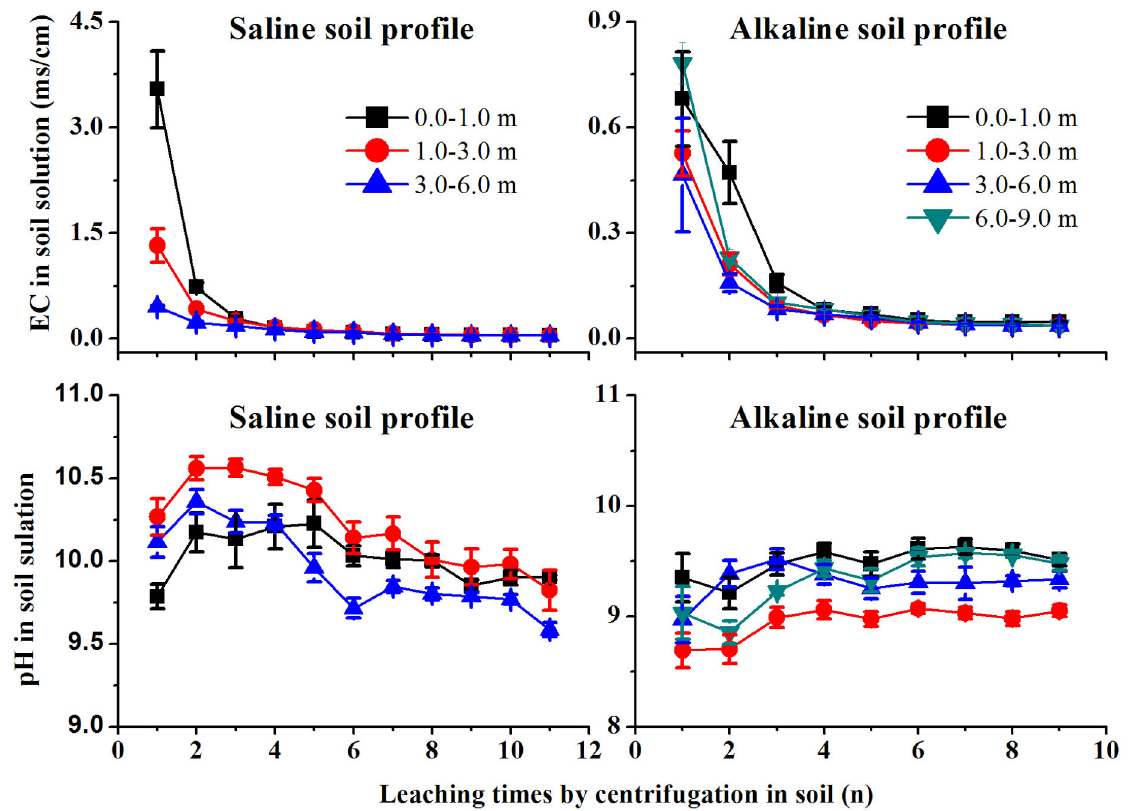
Figure 1. The changes of mean pH and EC values and standard error in the soil-water extracts by centrifugation.